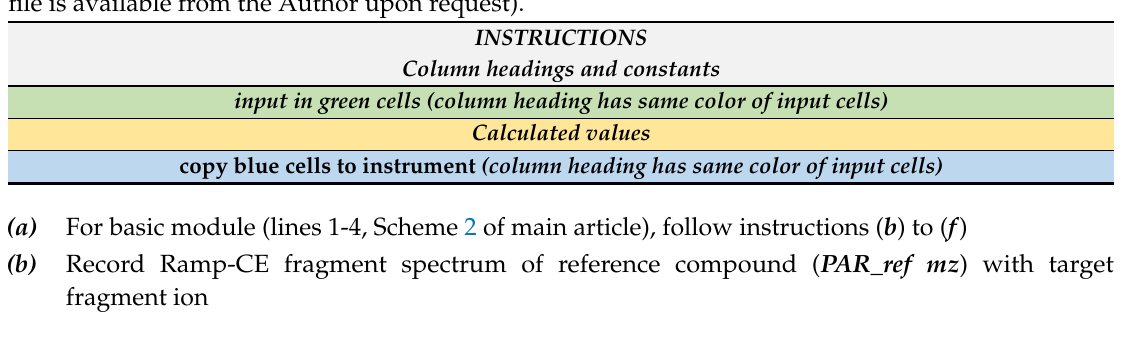
Supplementary Materials: The following are available online. Table S1. Structures of the examined dabsyl-amino acids, Figures S2 and S3. Measurement of representative CE max and calculation of the scan line (DABS-AA), Table S4. Structures of the examined nucleosides, Figure S5, S6. Measurement of representative CEmax of riboside transition MH + (cid:27) BH + and calculation of the scan line, Figure S7. Comparison of the generation e ffi ciency curves of the BH + fragment of protonated guanosine in Fragment Ion and in Neutral Loss spectra. Figure S8. ESI source spectrum of a mixture of nucleosides. Figure S9. Fragment ion spectrum of a protonated N6-subsituted adenosine (12), Table S10. Experiments for the measurement of nucleosides. Figure S11. Relative abundance of nucleosides in di ff erent conditions. Figure S12. Stability of signal in fast-scan i-CE Neutral Loss spectra. Figure S13. Comparison of CE lab in a continuous and stepped scan of collision